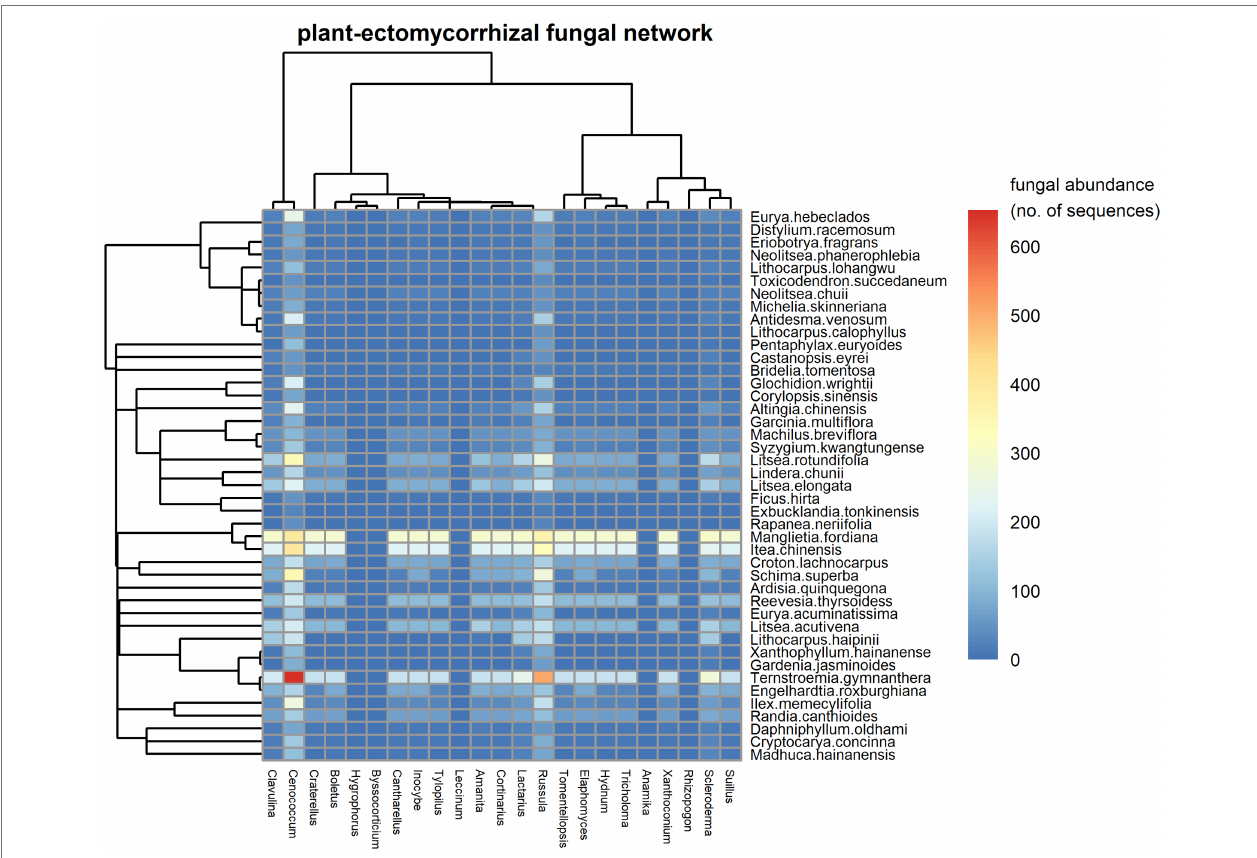
FIGURE 1 | A visual plot in the plant-ectomycorrhizal (EM) fungal network. Fungal genera are shown in columns and plant species are denoted in rows. Interaction frequency of plant species and fungal genera is filled in each cell and calculated as the mean of abundance (sequenced reads) of each genus of EM fungi on each host tree with the number rounded to the nearest integer. The abundance of each genus of EM fungi on each host tree is estimated after subsampling each sample to 3,000 sequence reads. In the figure, the color scales with interaction frequencies (fungal abundances on host plants). High fungal abundances on plants are shown in red, but low fungal abundances on plants are shown in blue. The dendrograms tree for plant species (left) and EM fungal genera (top) are also shown.